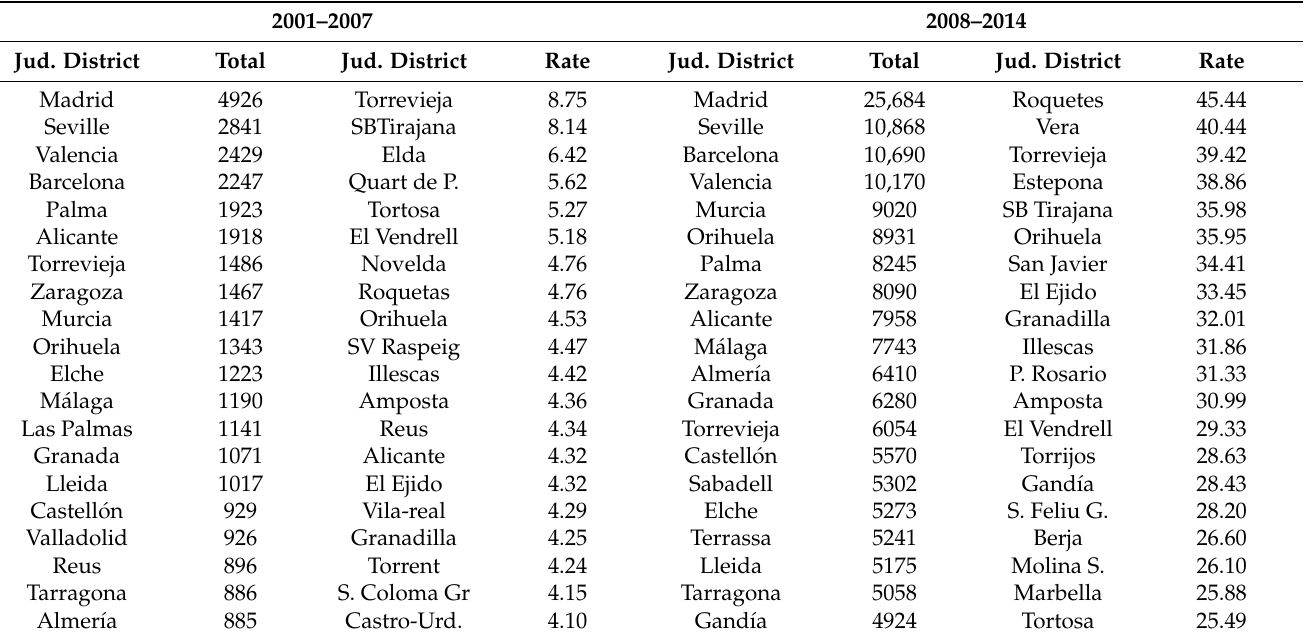
Table 1. The twenty judicial districts with the highest number of mortgage foreclosures (EH), the total number and rate per 1000 inhabitants in Spain